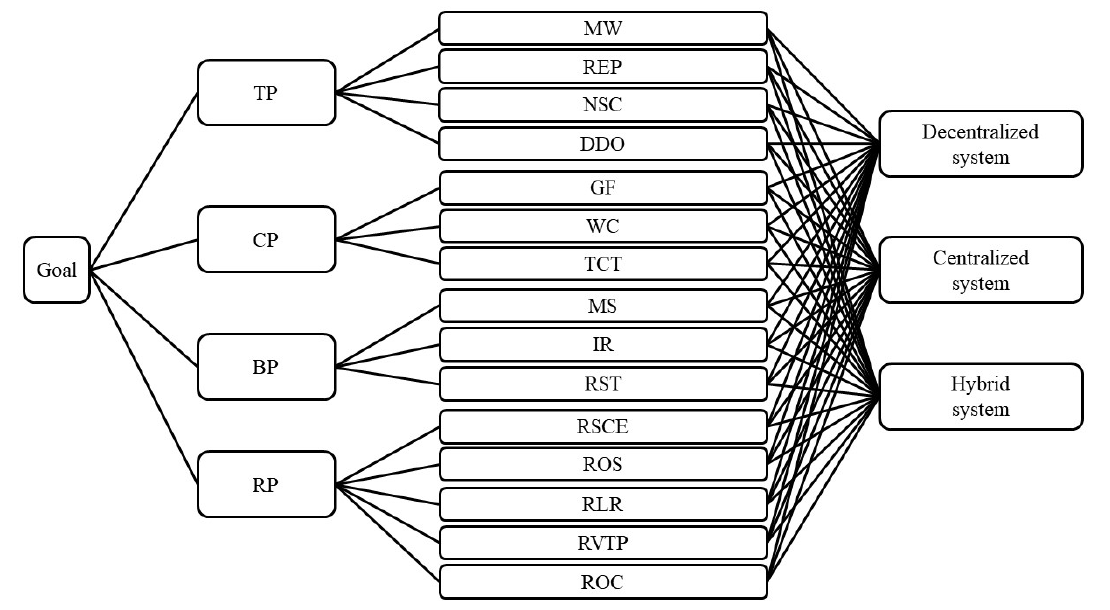
Figure 3. The research framework to evaluate the optimal cryptocurrency trading systems and critical parameters.